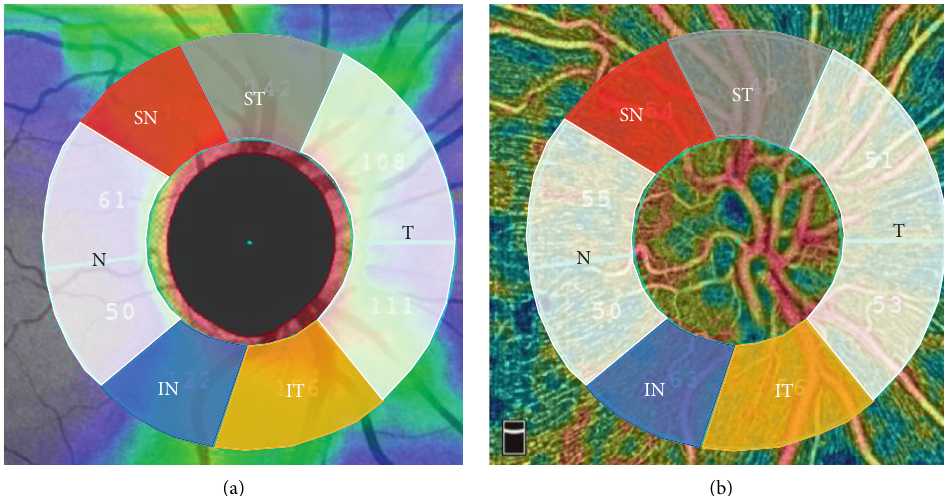
Figure 1: Optical coherence tomography angiography of (a) the retinal nerve fiber layer and (b) radial peripapillary capillary layer of the left eye (OS) with the Garway–Heath map sectors: temporal (T) in white color), superior temporal (ST, in gray color), inferior temporal (IT, in orange color), nasal (N) in white color), superior nasal (SN, in red color), and inferior nasal (IN, in blue color)